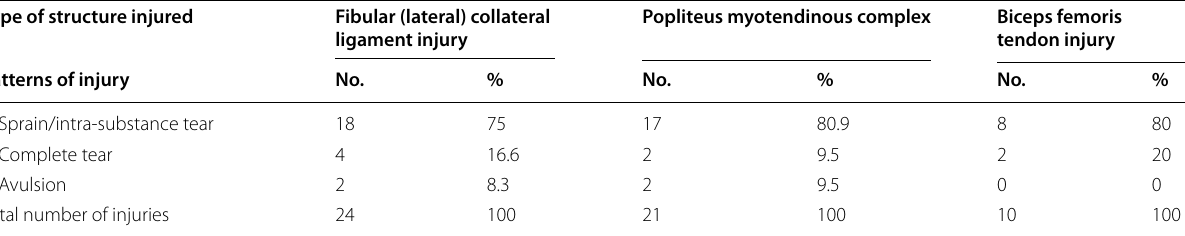
Table 4 Correlation between different patterns of injury of the commonly encountered PLC structures Type of structure